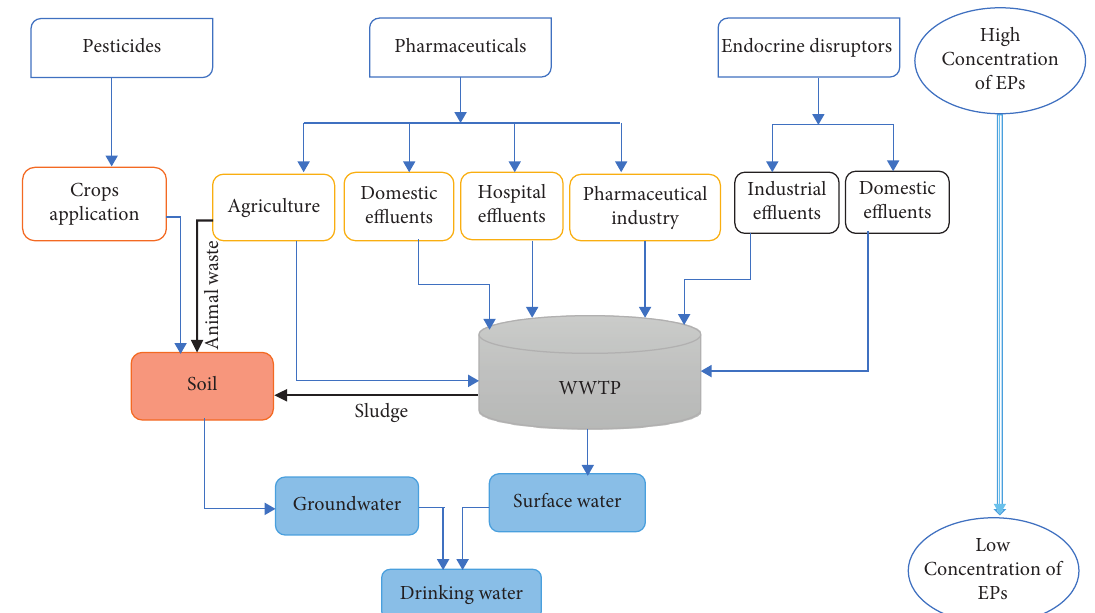
Figure 1: Pathways of EPs from the source to the aquatic